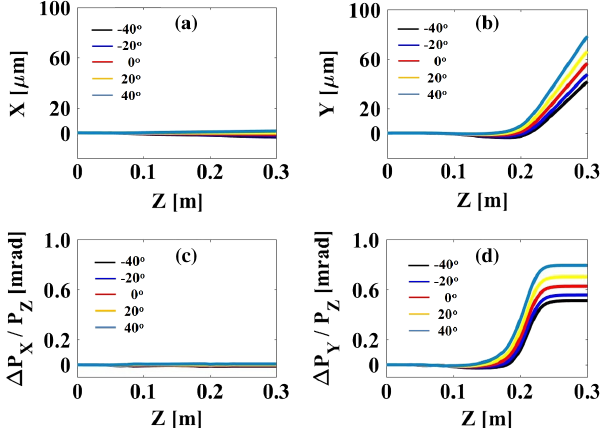
FIG. 4. Off-center distance of the beam centroid and the characterized kick strength for different rf start-phases. Note that 0° in the legends corresponds to the gun phase for the maximum mean momentum gain